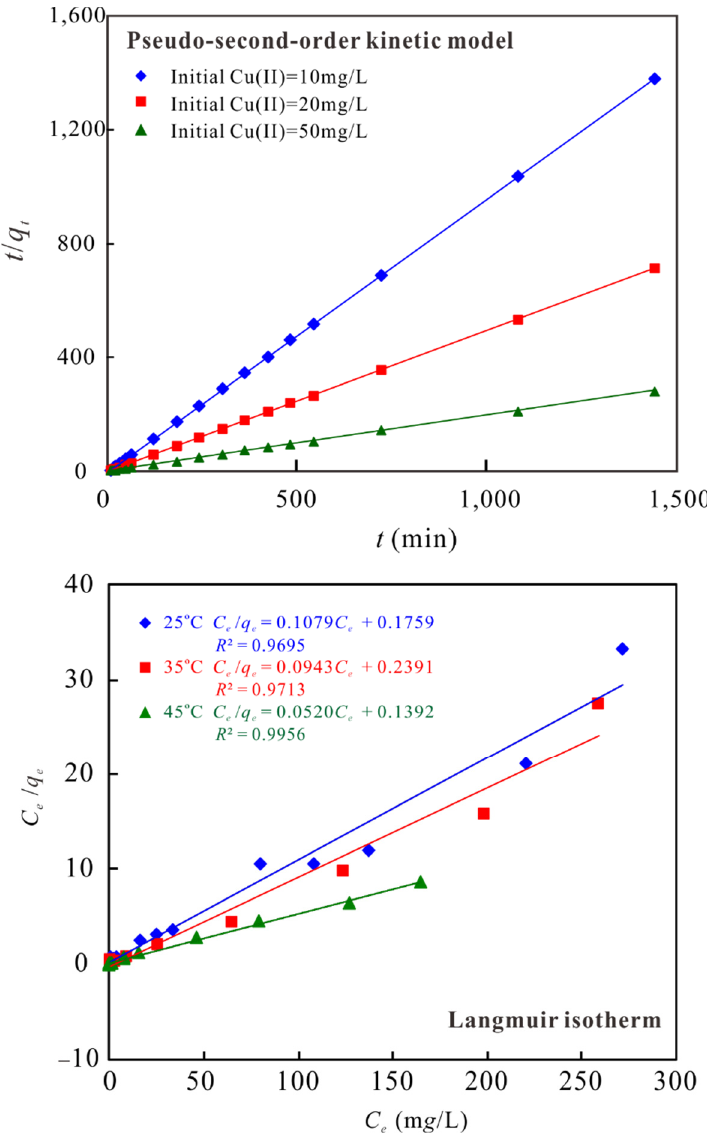
Figure 11. Kinetics and isotherm for Cu (II) removal by the SC–HA/C composite.